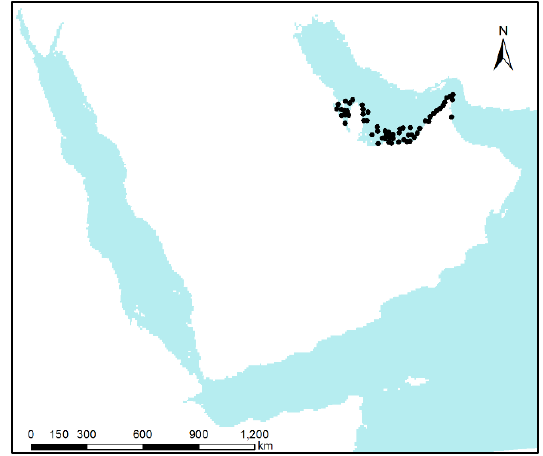
Figure 1. Occurrence points used for the distribution modelling.